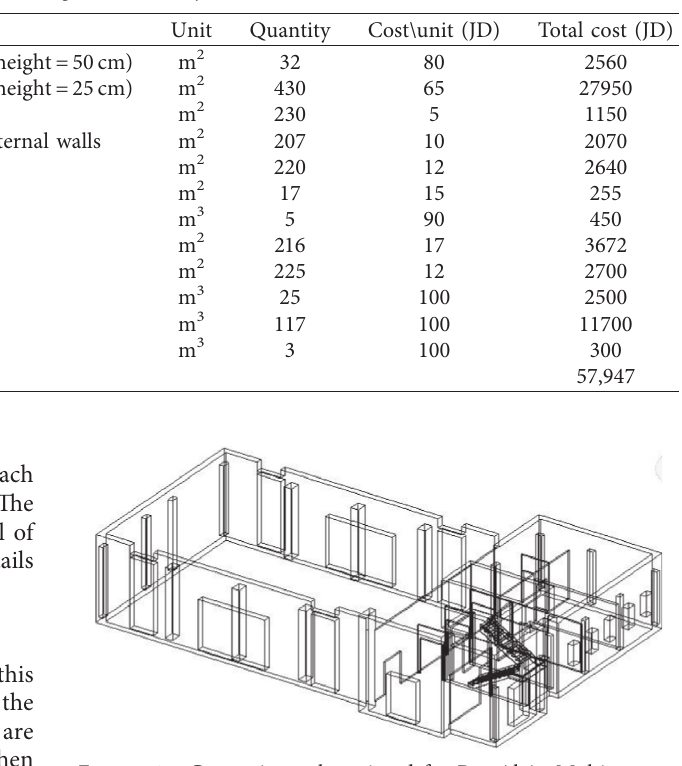
Figure 17: Categories to be printed for Ras Alain Multipurpose Hall.